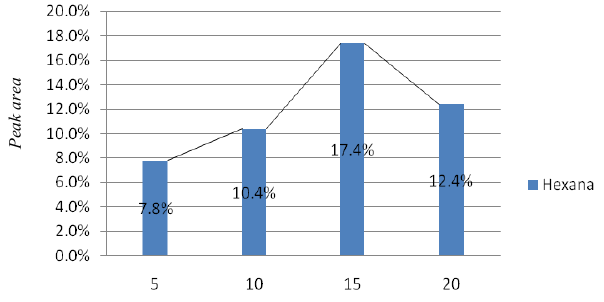
Equilibrium time, Figure 6. Equilibrium time profile.